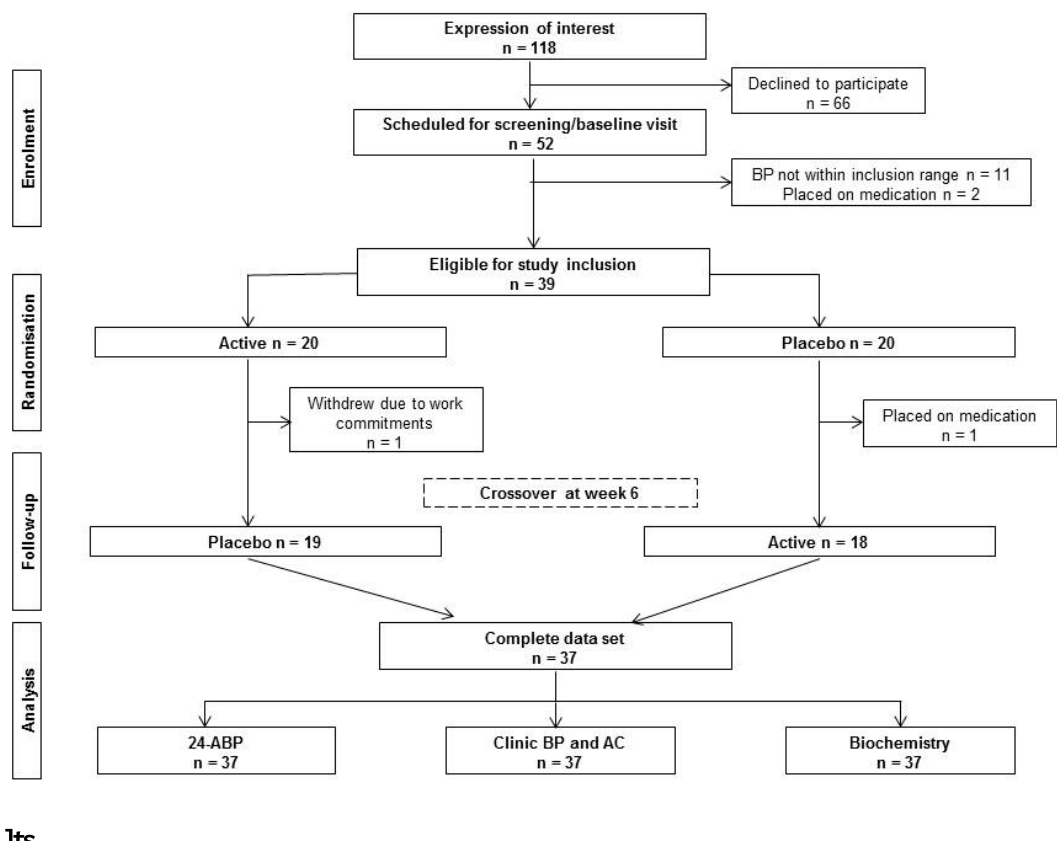
Figure 2. Consolidated Standards of Reporting Trials (CONSORT)